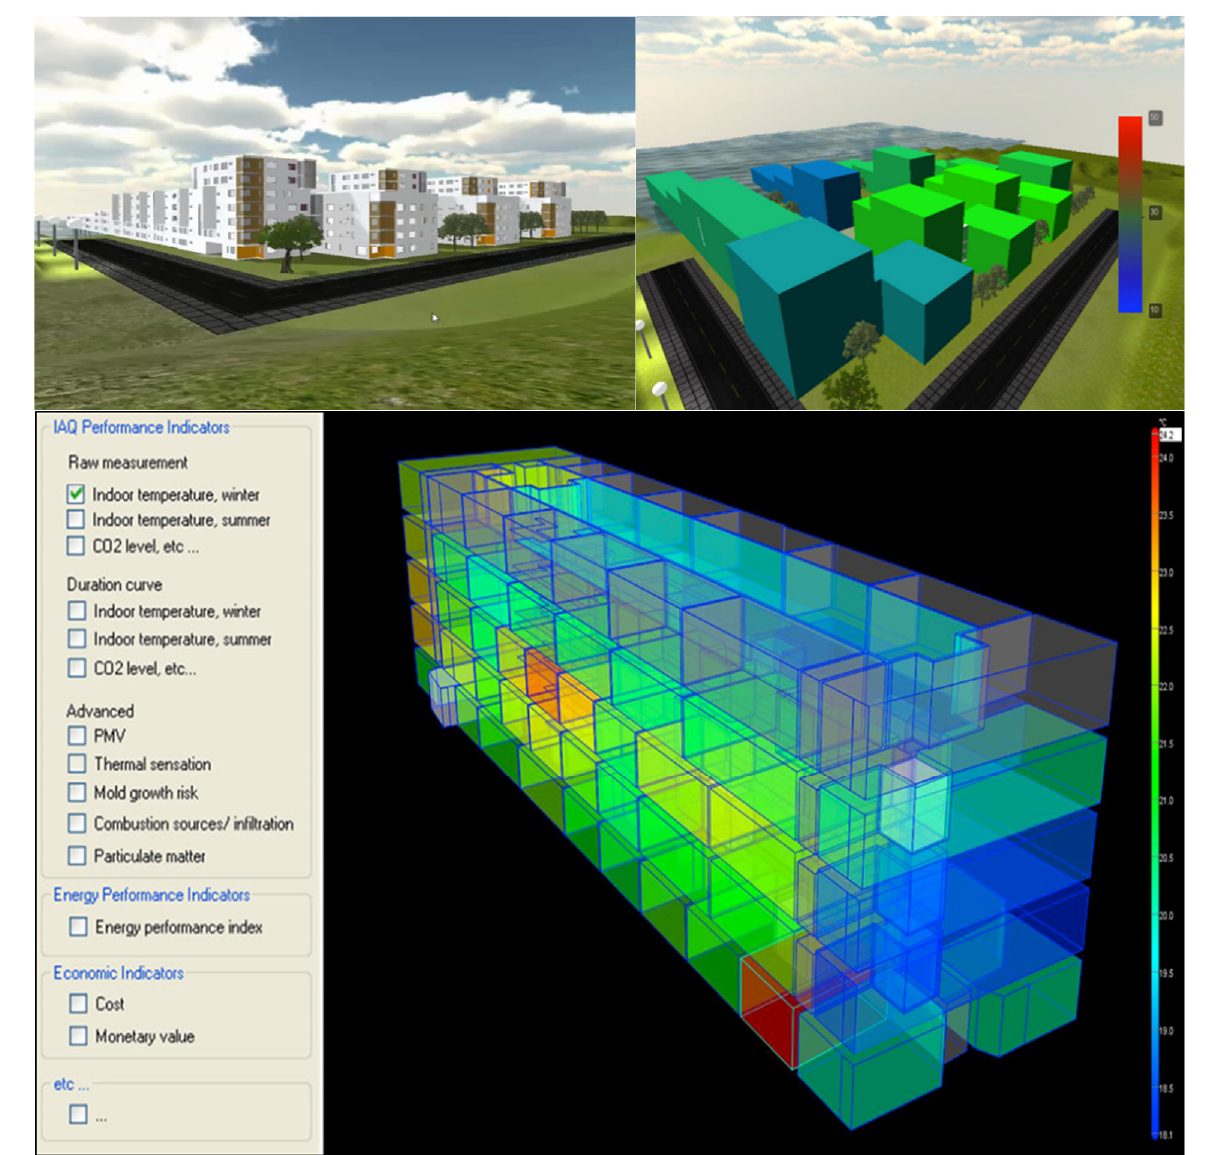
Figure 9. Case study no. 1 for expressing use of BIM in energy modeling: building block in Skopje, North Macedonia.